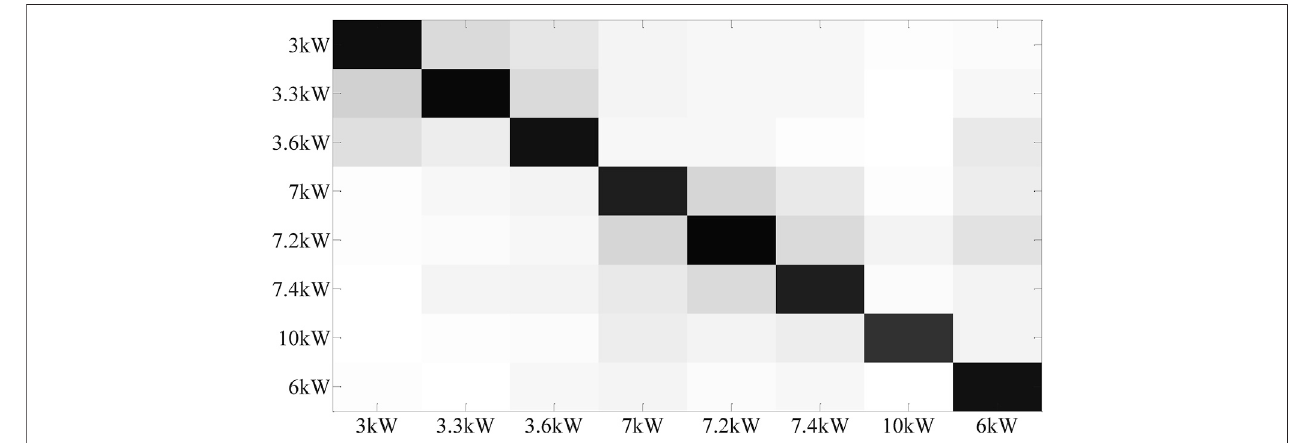
FIGURE 6 | Confusion matrices on different types of